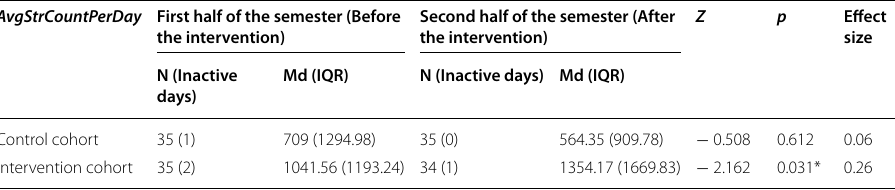
∗ p is significant at the 0.05 level